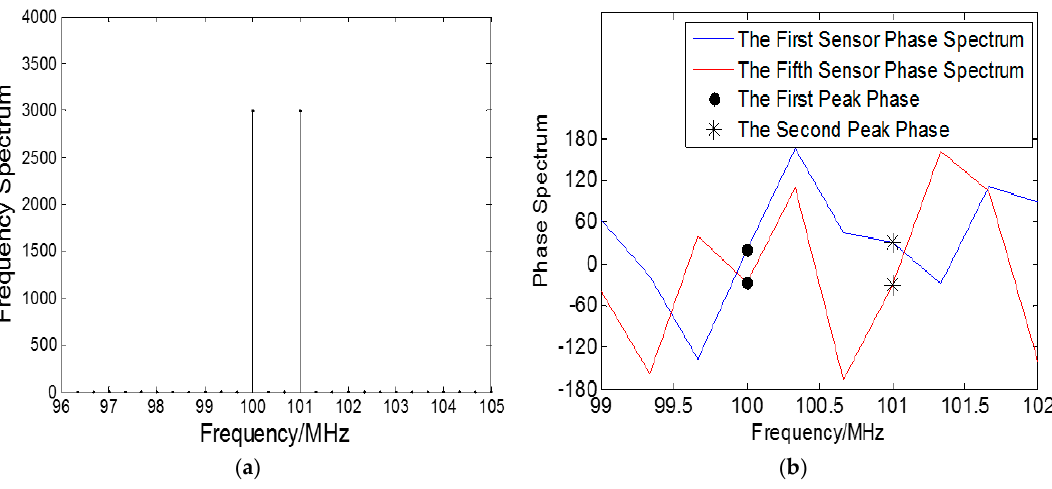
Figure 4. Mixed incoherent sources signal spectrums: ( a ) The first sensor frequency spectrum; ( b ) The first sensor and fifth sensors phase spectrum.